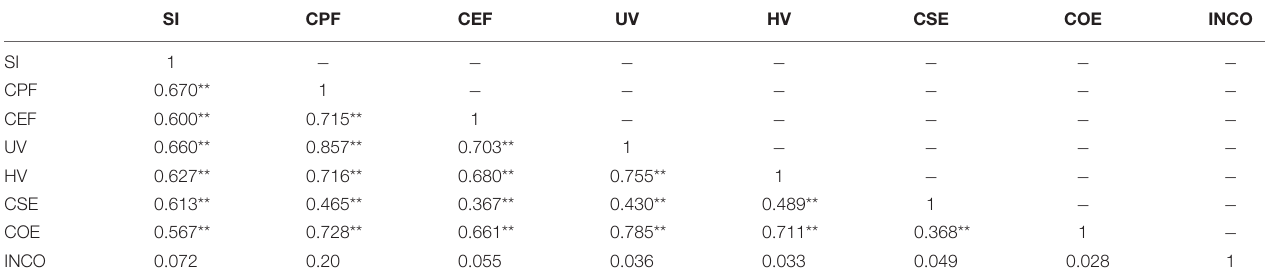
TABLE 2 | Correlation coefficient matrix of the marker variable and other